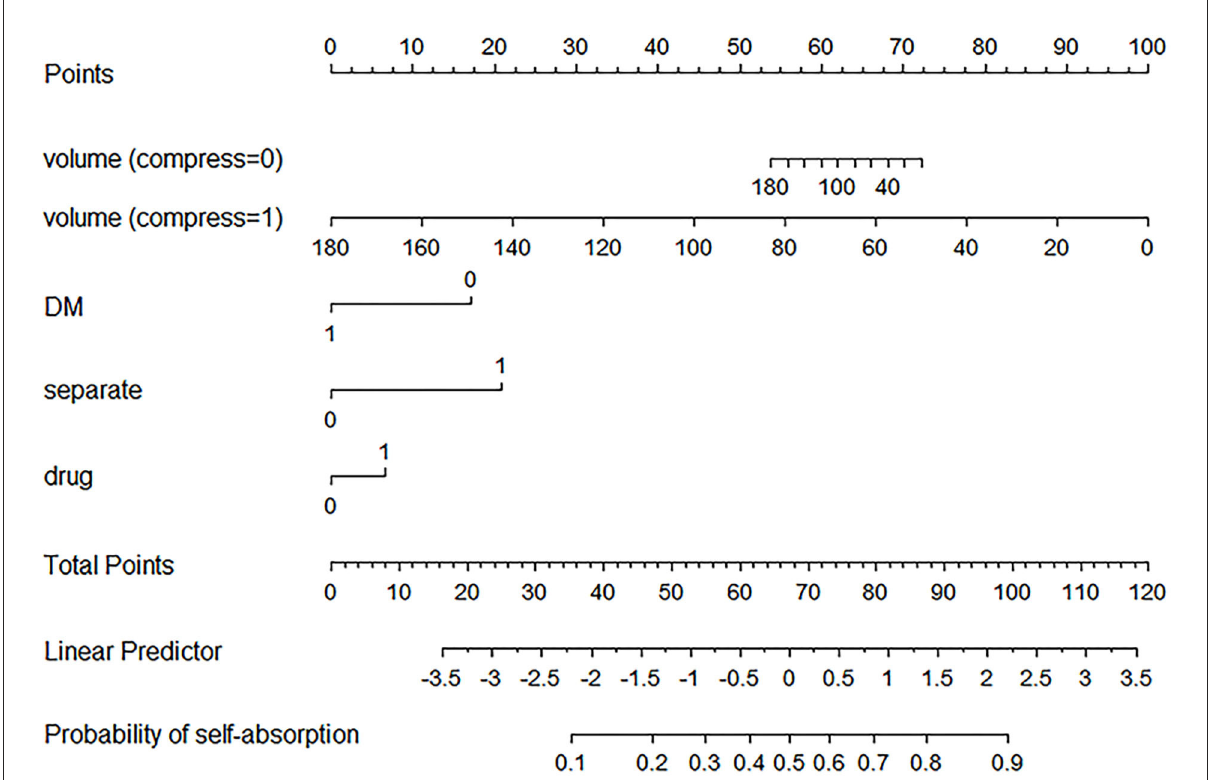
FIGURE3 Established nomogram. The nomogram was developed in the primary cohort, with a history of diabetes mellitus (8), the use of atorvastatin (drug), hematoma volume (volume), presence of basal ganglia compress (compress), and presence of septate hematoma (separate) incorporated.